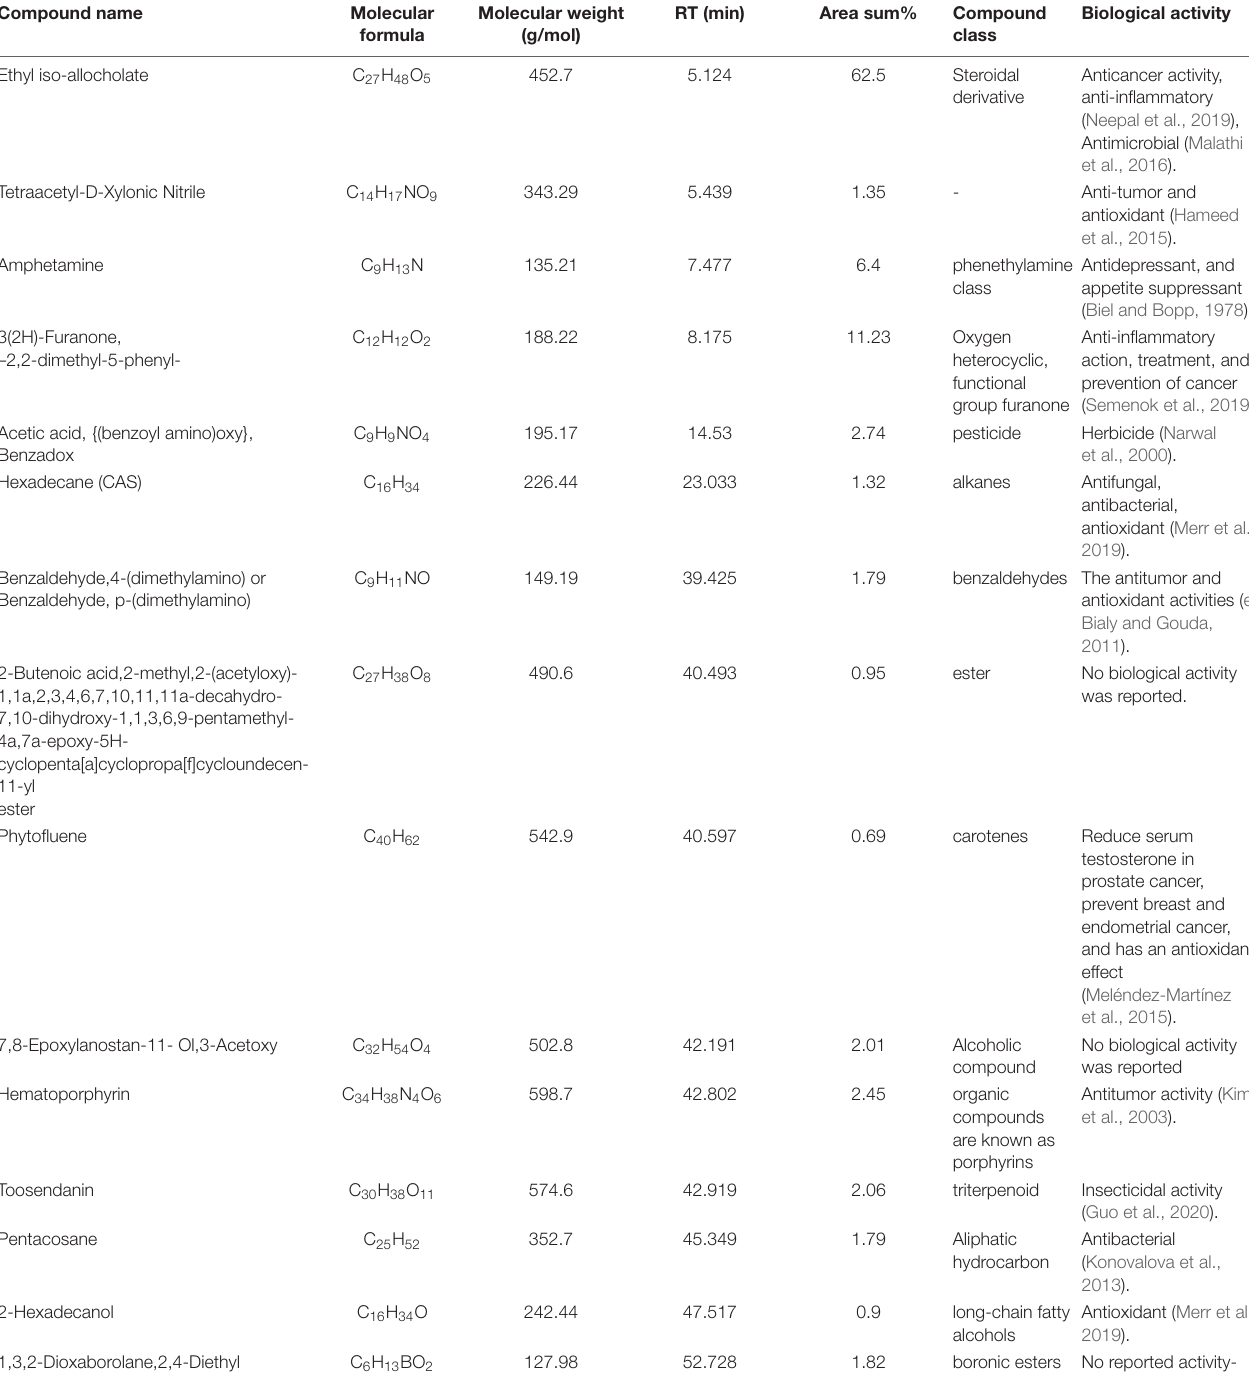
TABLE 7 | Chemical profile identified from the Pleurotus ostreatus polar extract by GC-MS